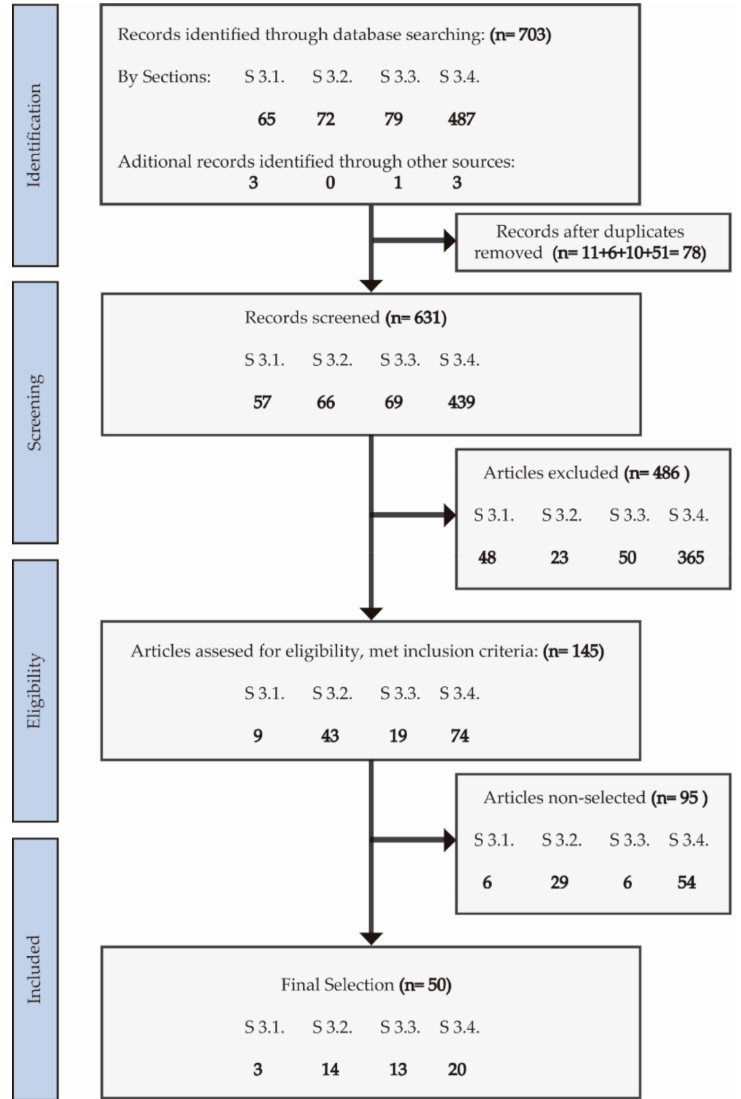
Figure 1. Methodological flowchart following preferred reporting items for systematic review based on